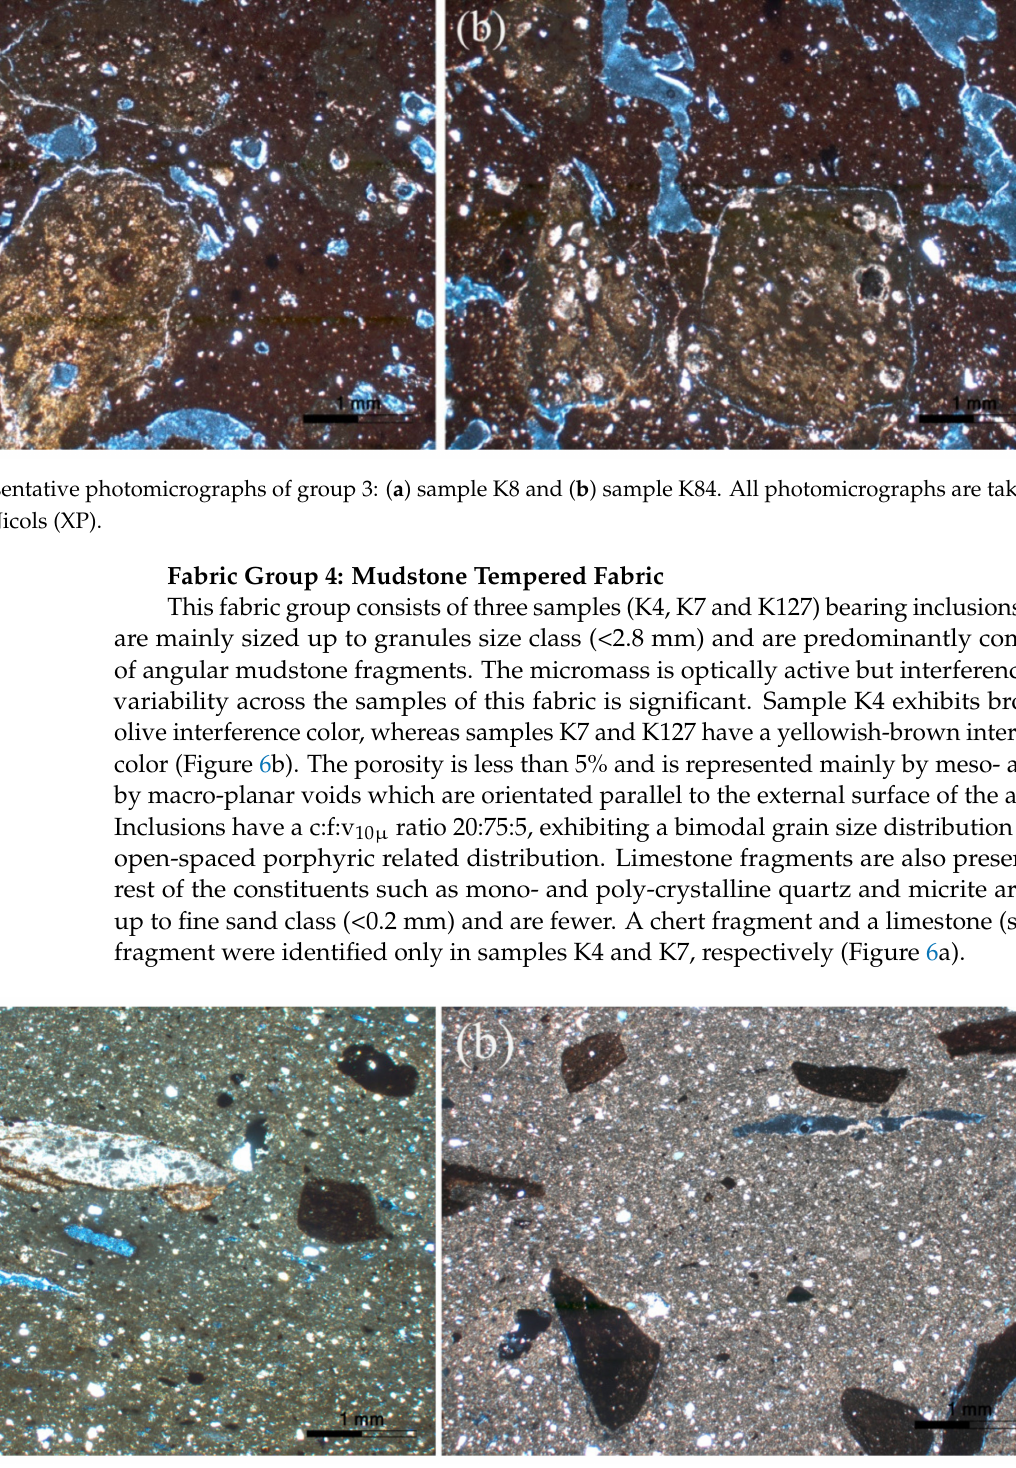
Figure 6. Photomicrographs of the fabric group 4: ( a ) sample K7 and ( b ) K127. All photomicrographs are taken under crossed Nicols